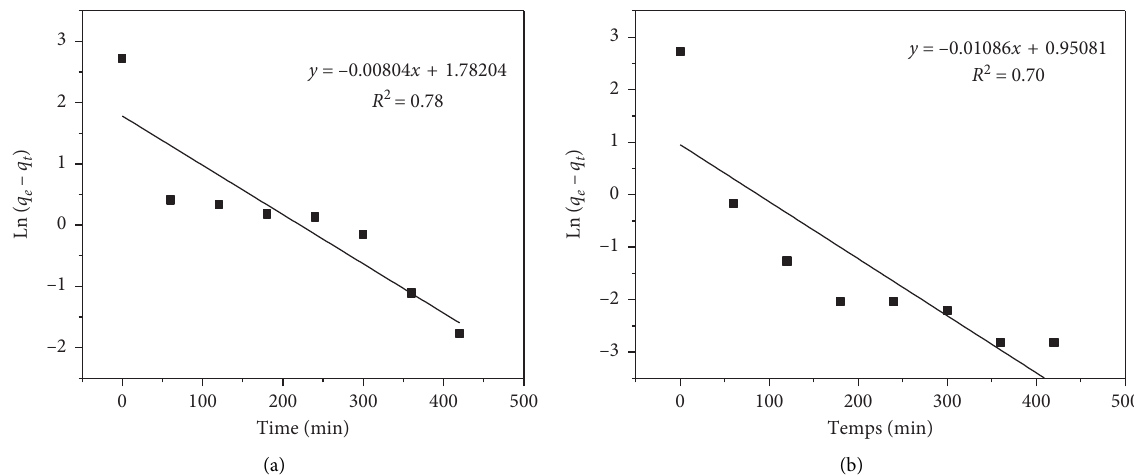
Figure 7: Plots of the first-order kinetics of MB dye adsorption on the geopolymer (a) without UV and (b) with